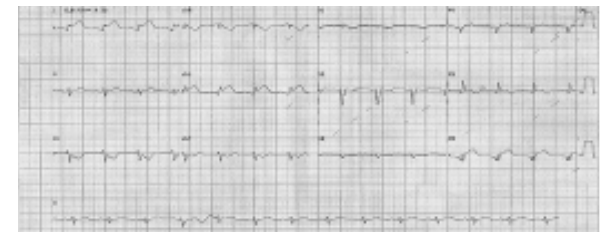
Fig. 1B - Pós-operatório imediato antes do re-estudo